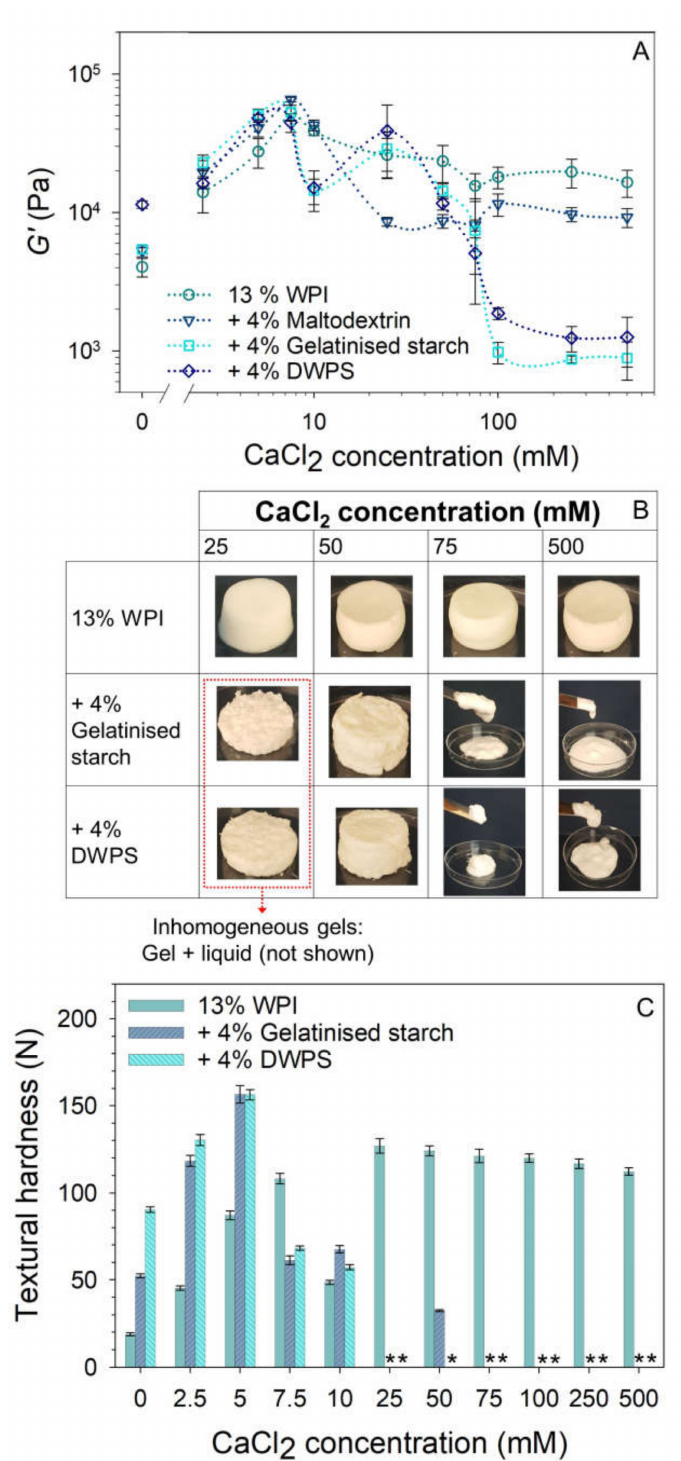
Figure 5. Effect of CaCl 2 on the: ( A ) G (cid:48) from frequency sweep at 1% strain and 1 Hz frequency of 13% w / w WPI and 13% w / w WPI + 4% w / w maltodextrin, gelatinised starch or DWPS with 0–500 mM CaCl 2 at 20 ◦ C. Lines in the graphs serve as visual aids, ( B ) visual appearance of 13% w / w WPI and 13% w / w WPI + 4% w / w gelatinised starch or DWPS at 25, 50, 75 and 500 mM CaCl 2 , and ( C ) textural hardness of 13% w / w WPI and 13% w / w + 4% w / w gelatinised starch or DWPS with 0–500 mM CaCl 2 at room temperature. Values are plotted as means ± standard error. Note that compressed test was not performed on inhomogeneous/paste-like gels (denoted with